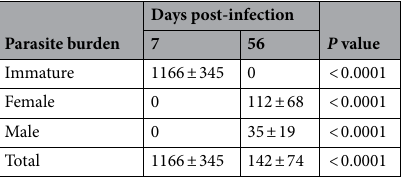
Table 1. Parasite burdens of Creole goat kids at 7- and 56-days post-infection with 10,000 H. contortus infective larvae (L3).